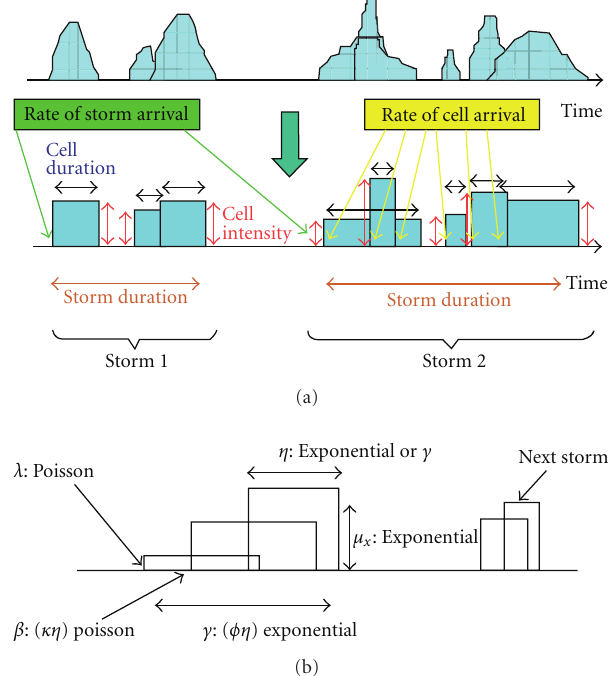
Figure 1: (a) Explanatory sketch for the structures of rainfall storms. (b) Explanatory sketch for the parameters of Bartlett-Lewis rectangular pulses model.